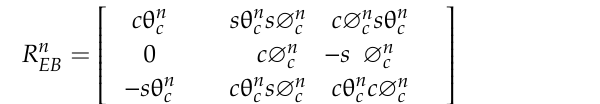
Figure 8. Illustration of the discrete representation of the underwater cable.